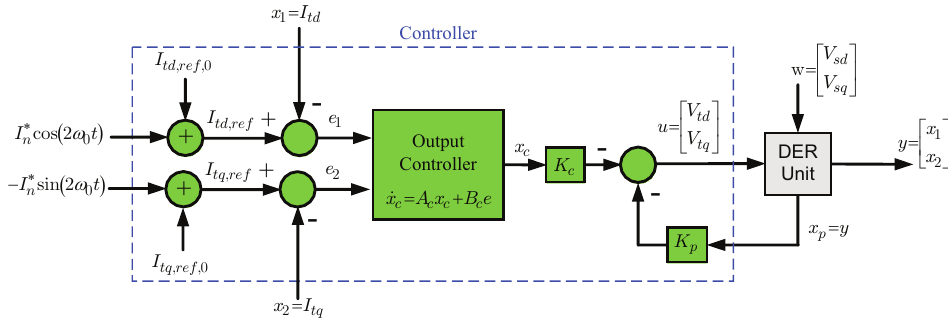
Figure 3. The structure of the proposed control